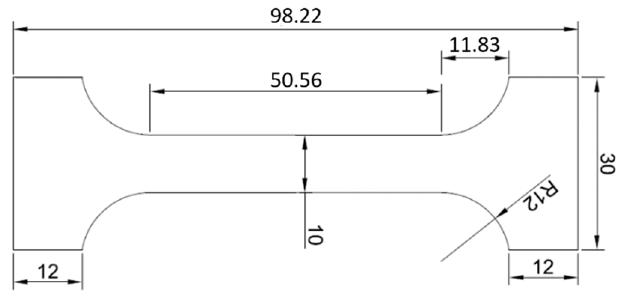
Figure 1. Test piece of solder for the static tensile test (unit: mm).